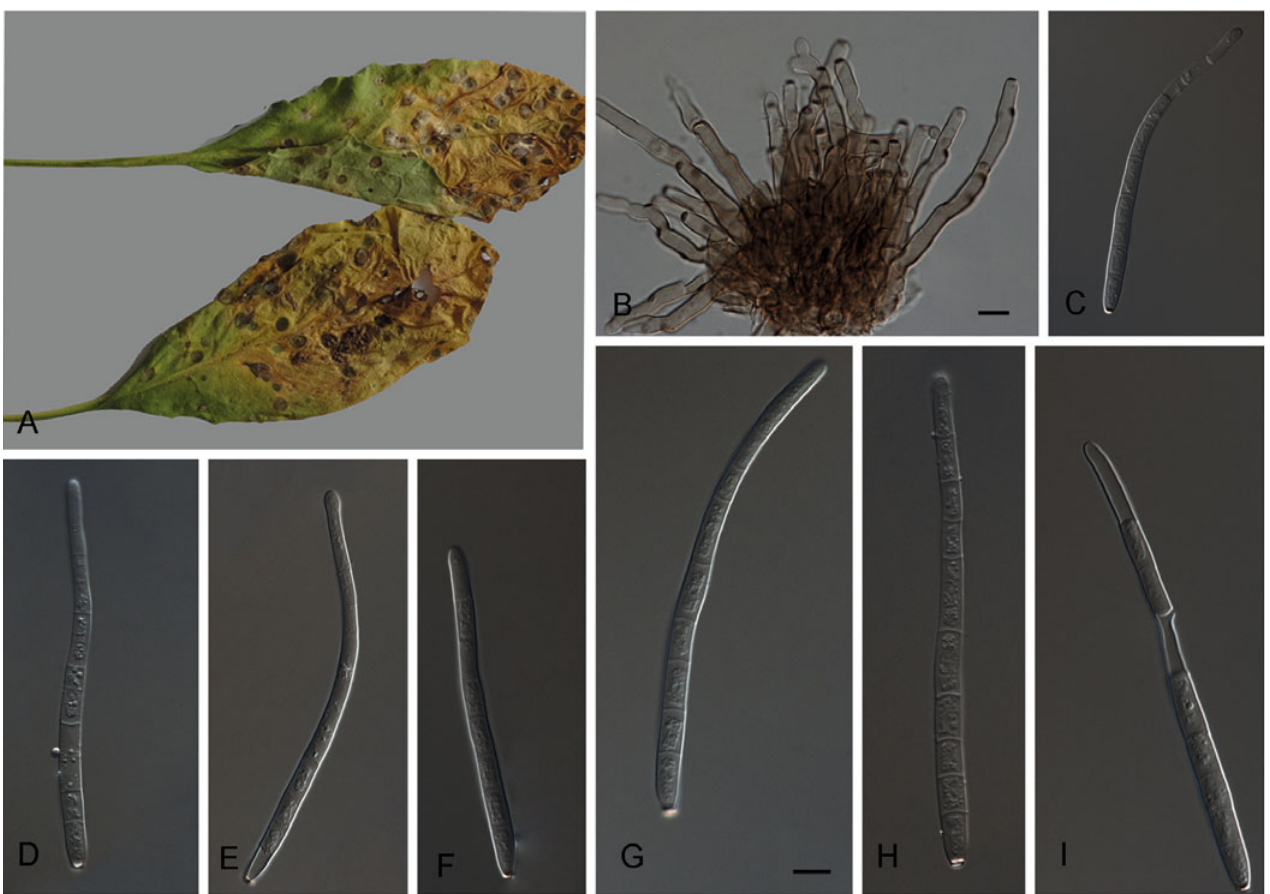
Fig. 5. Cercospora bizzozeriana (cid:2)(cid:24)%’7(cid:2)!.$!.*(cid:27)(cid:28)(cid:2) A–B. (cid:2)S(cid:13)(cid:9)(cid:26)(cid:2)(cid:7)(cid:18)(cid:4)(cid:8)(cid:7)(cid:28)(cid:2) C. (cid:2)2(cid:9)(cid:7)(cid:19)(cid:11)(cid:19)(cid:5)(cid:23)(cid:9)(cid:8)(cid:13)(cid:2)(cid:19)(cid:4)(cid:17)(cid:11)(cid:21)(cid:11)(cid:4)(cid:18)(cid:14)(cid:4)(cid:10)(cid:13)(cid:7)(cid:28)(cid:2) D–J.